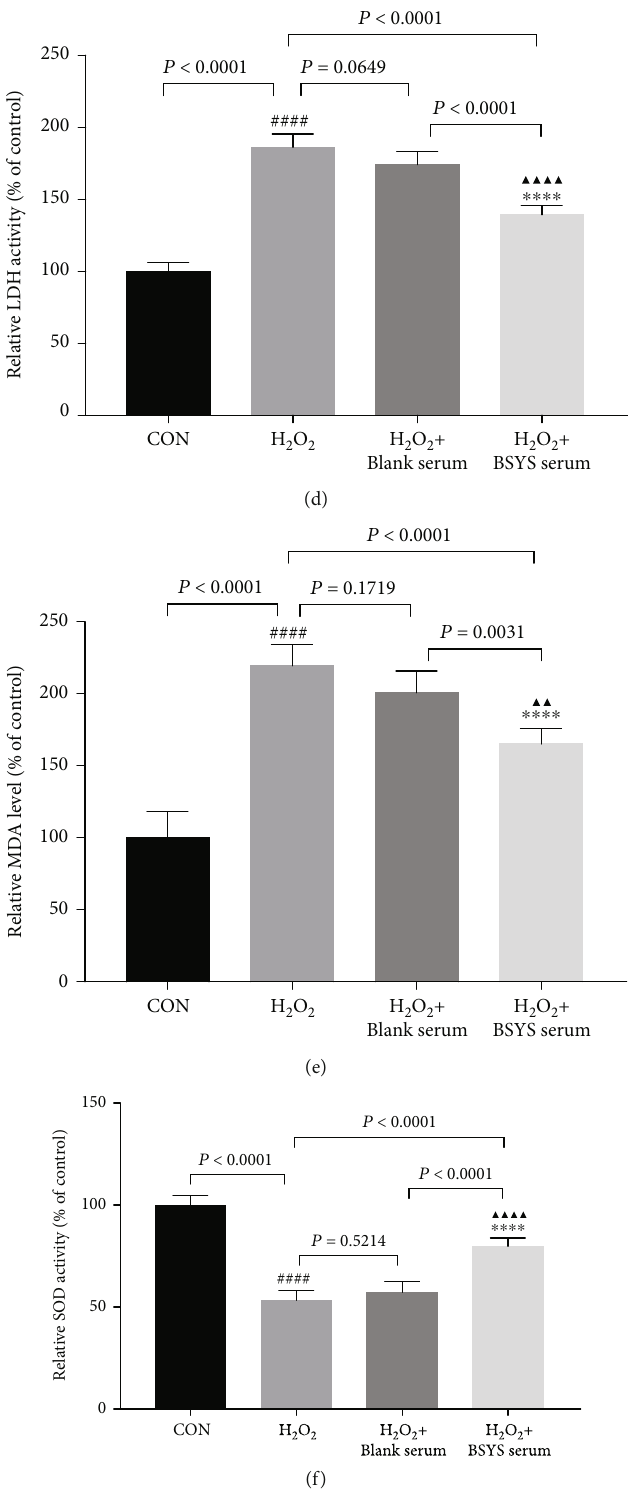
Figure 6: BSYS serum alleviates H by CCK-8 assay. (b) Viability of OLN-93 cells exposed to various concentrations of H BSYS serum, OLN-93 cells were incubated with H serum (5%-25%) for 24 h. (d) LDH content, (e) MDA level, and (f) SOD activity of OLN-93 cells were measured by the corresponding commercial kit. Data are presented as means ± SD , compared with the CON group, #### P < 0 : 0001 ; compared with the H P < 0 : 0001 ; and compared with the H